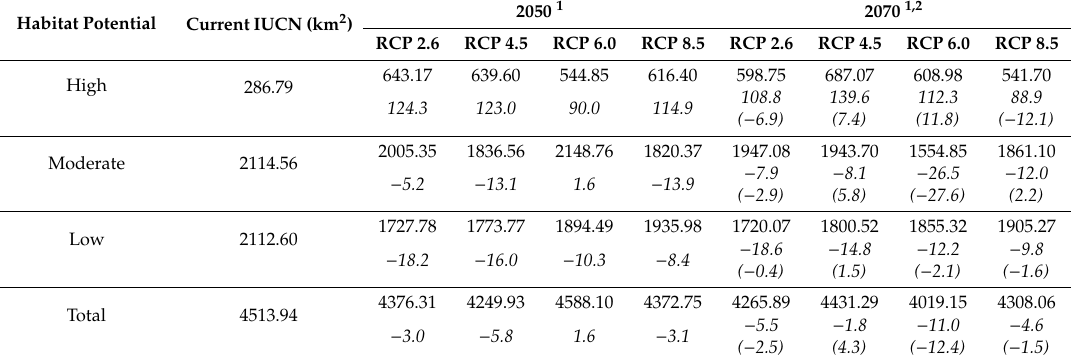
Table 4. Area (km 2 ) of the “existing” land area on the IUCN map that is indexed to the predicted potential distribution under current conditions and variation (%) in climate change scenarios of the spectacled bear in Amazonas